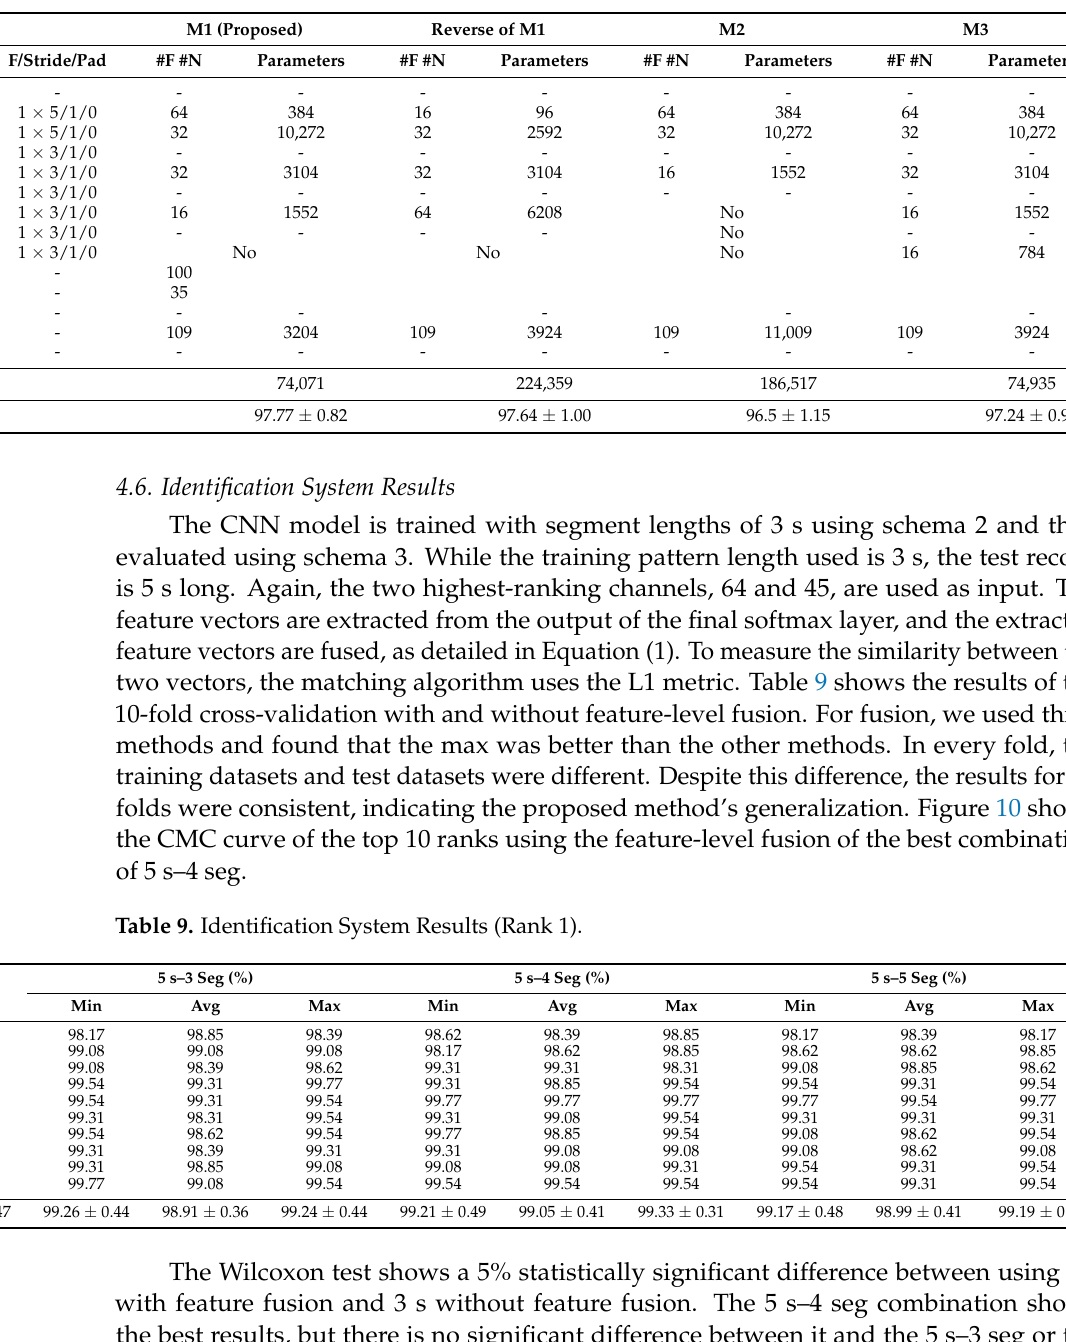
Table 8. Different Model Architectures, where: F: filters, #N: number of neurons, No: not in the model.